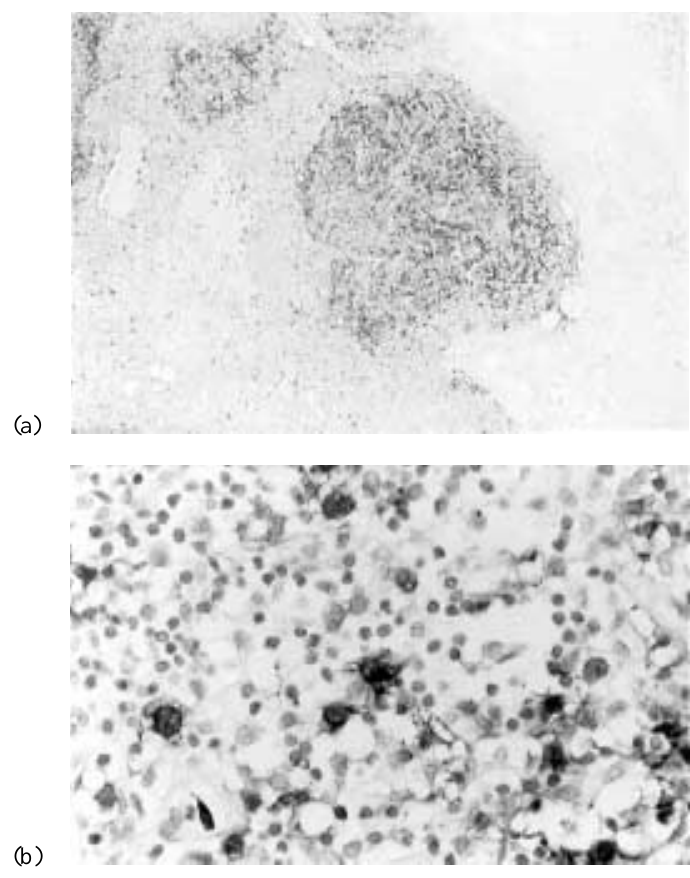
Fig. 1. Immunohistochemical staining performed with an S100 antibody on an axillary lymph node of a patient with locally advanced breast cancer. The large dark stained cells represent S100 positive cells. Figure 1(a) shows a lymph node stained for S100 in low magnification. Figure 1(b) shows a high magnification of the same lymph